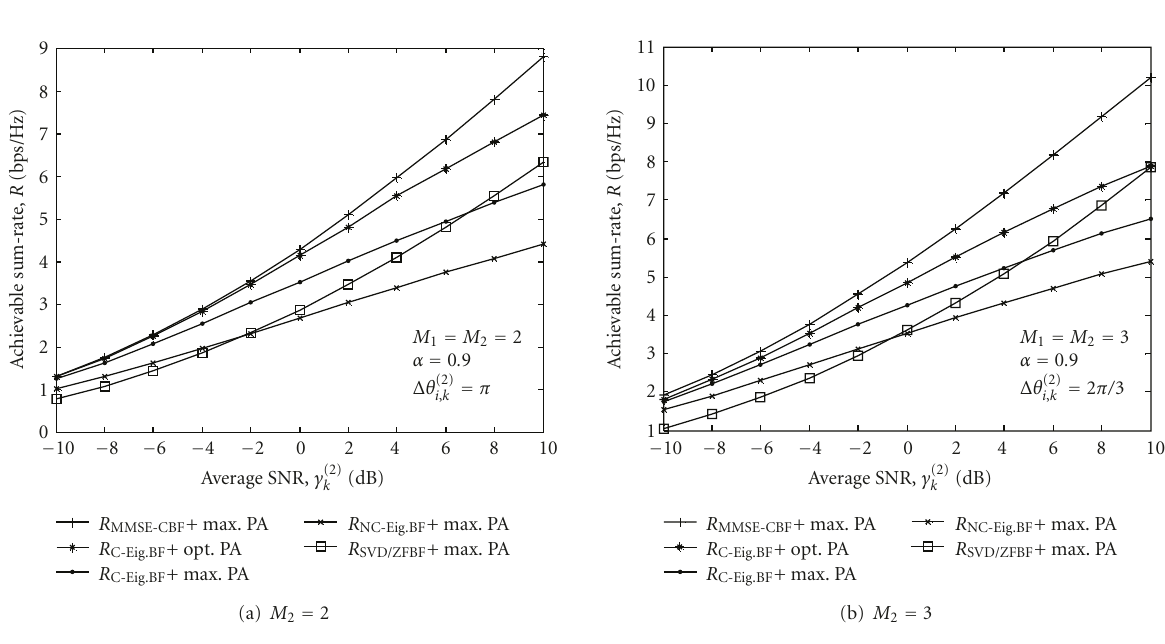
Figure 9: Performance comparison according to γ (2)